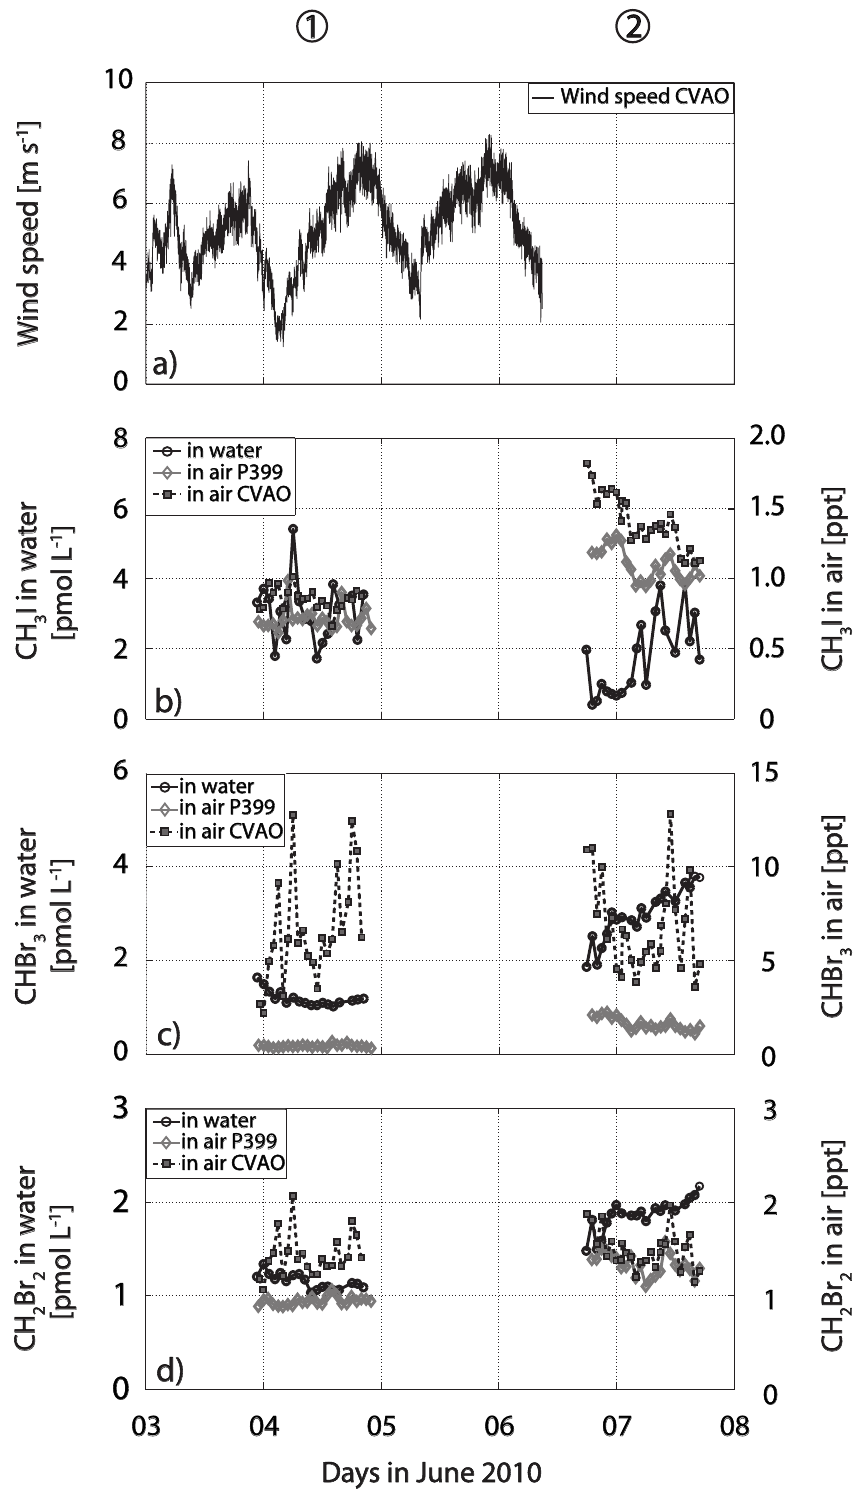
Fig. 3. Open ocean surface water and atmospheric halocarbons during stations S1 and S2 and atmospheric halocarbons measured parallel at CVAO as well as wind speed (wind speed in a , CH 3 I in b , CHBr 3 in c , and CH 2 Br 2 in d ). Wind speed data for 7 and 8 June in 2010 was not